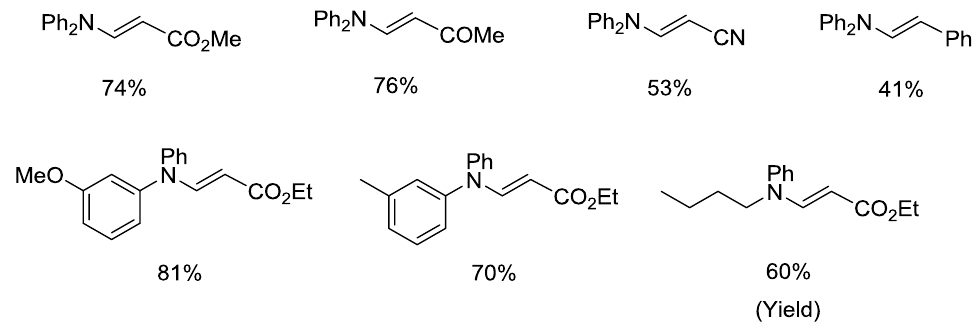
Scheme 1. Oxidative amination of secondary aromatic amines ( 1 ) and electron-deficient olefins ( 2 ), catalyzed by Pd(II)/NPMoV/HQ system. Conditions: secondary aromatic amines (2 mmol) were allowed to react with electron-deficient olefins (6 mmol) in the presence of PdCl (PhCN) (5 mol%) combined with NPMoV (1 mol%) and 2 2